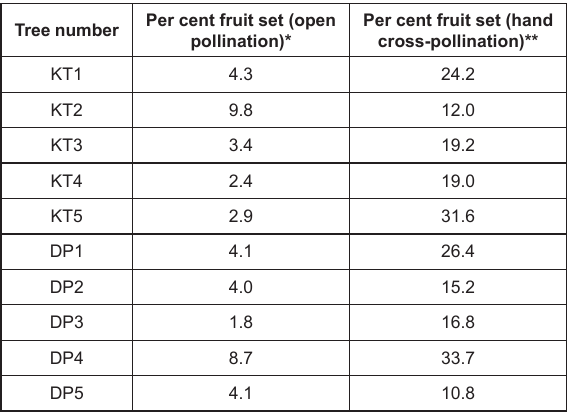
Table 2. Fruit set under open pollination and manual xenogamous cross-pollinations on 10 selected trees of Tirumala Hill population Per cent fruit set (open Tree number